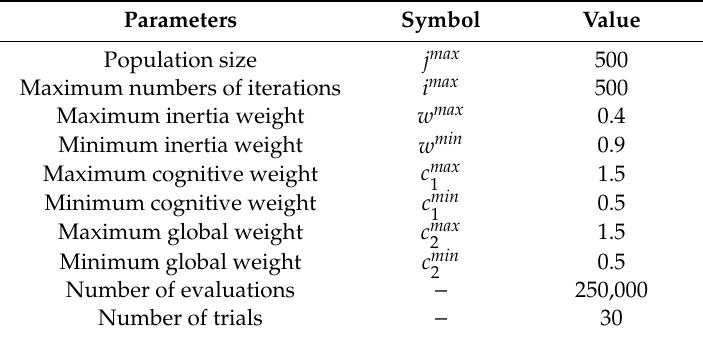
Table 3. Particle swarm optimization (PSO) parameters used.